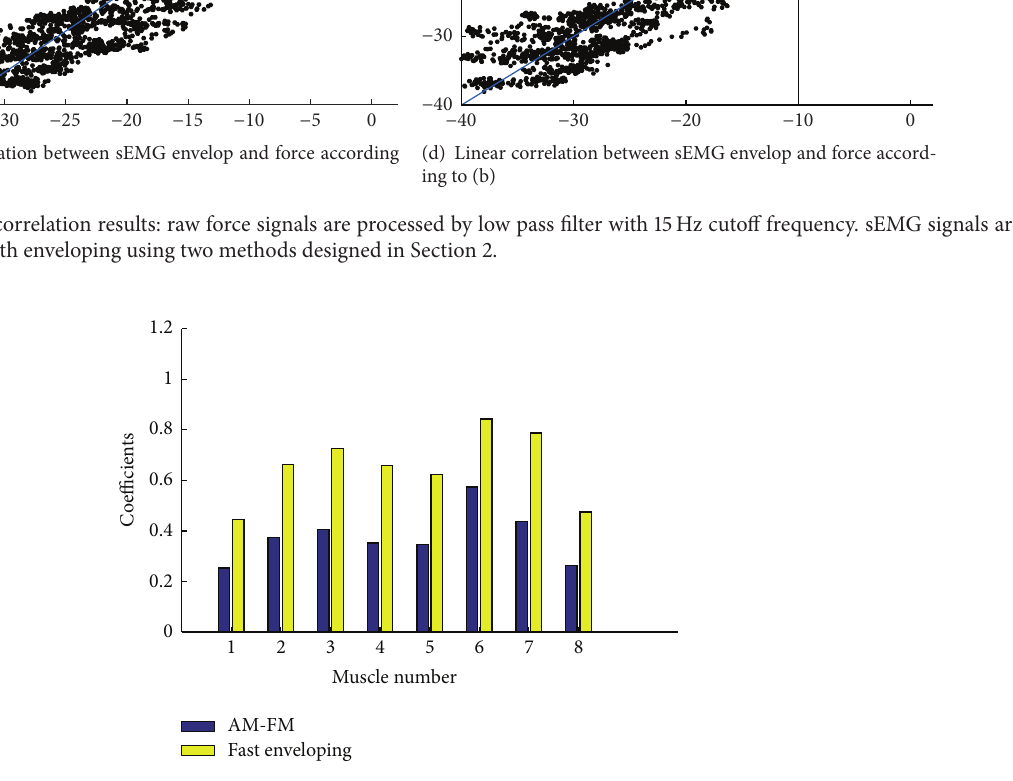
Figure 13: Stiffness coefficients estimation results: the value of coefficients indicates different contributions of muscles to the human arm